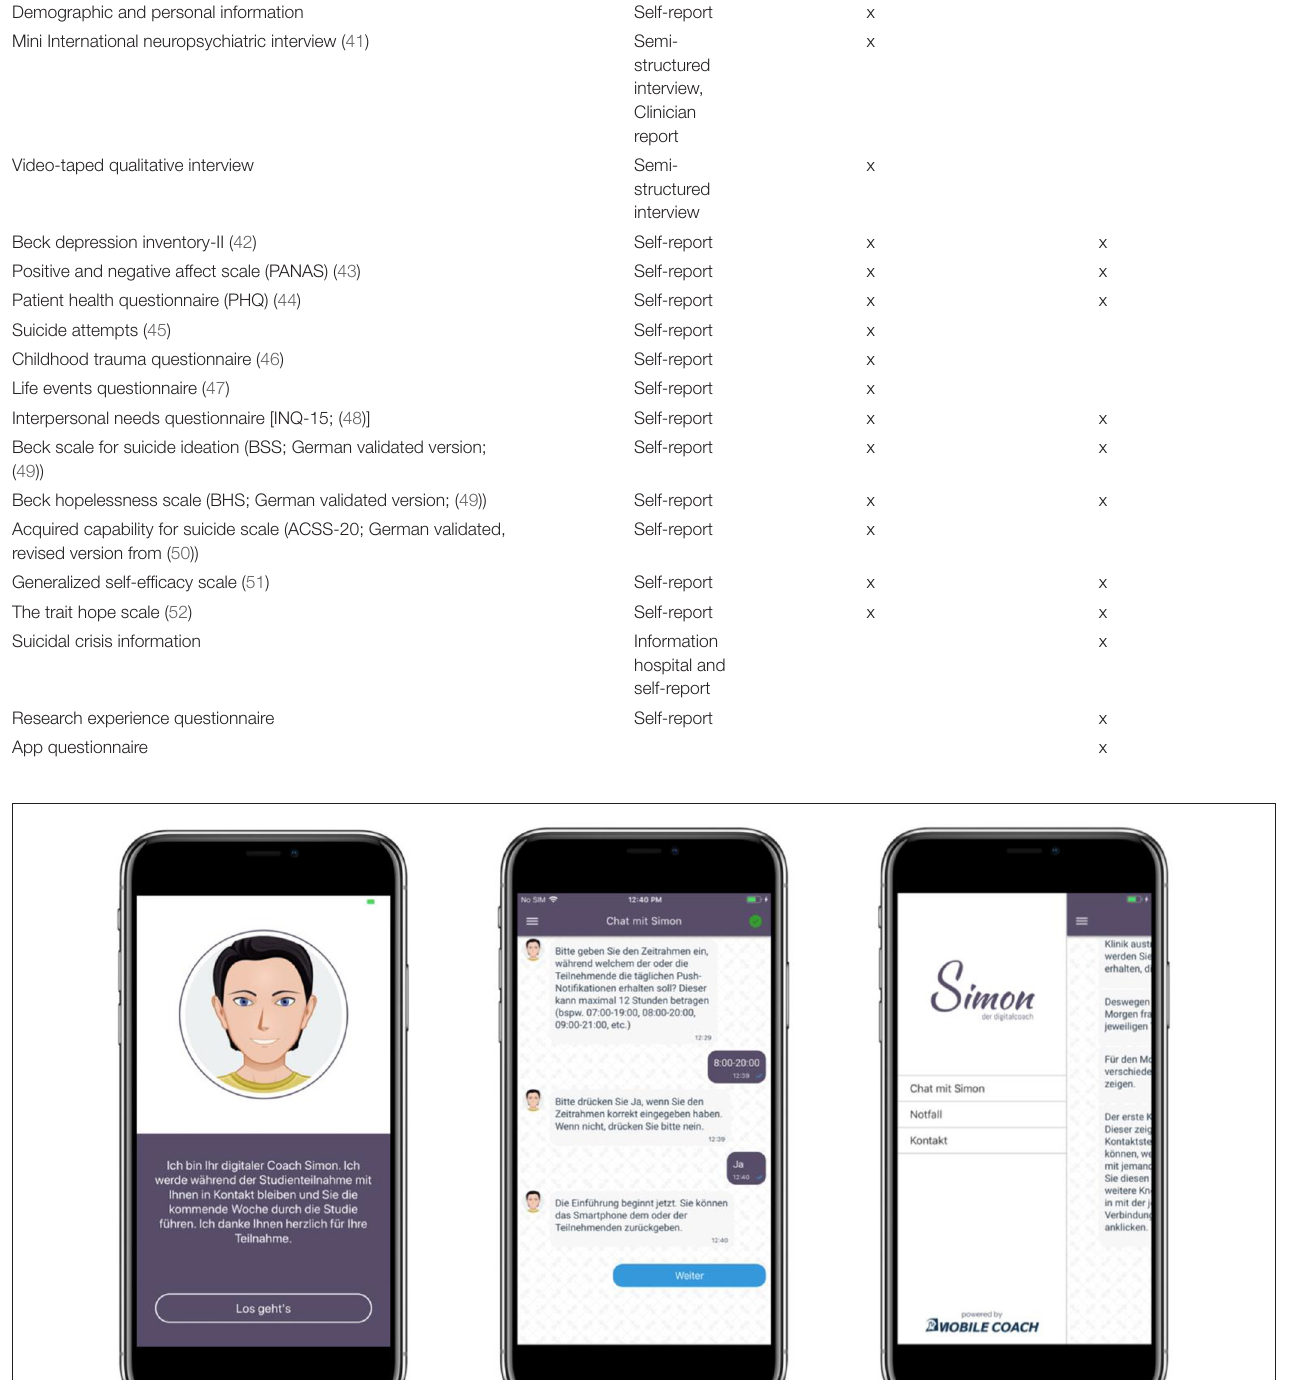
Frontiers in Psychiatry |